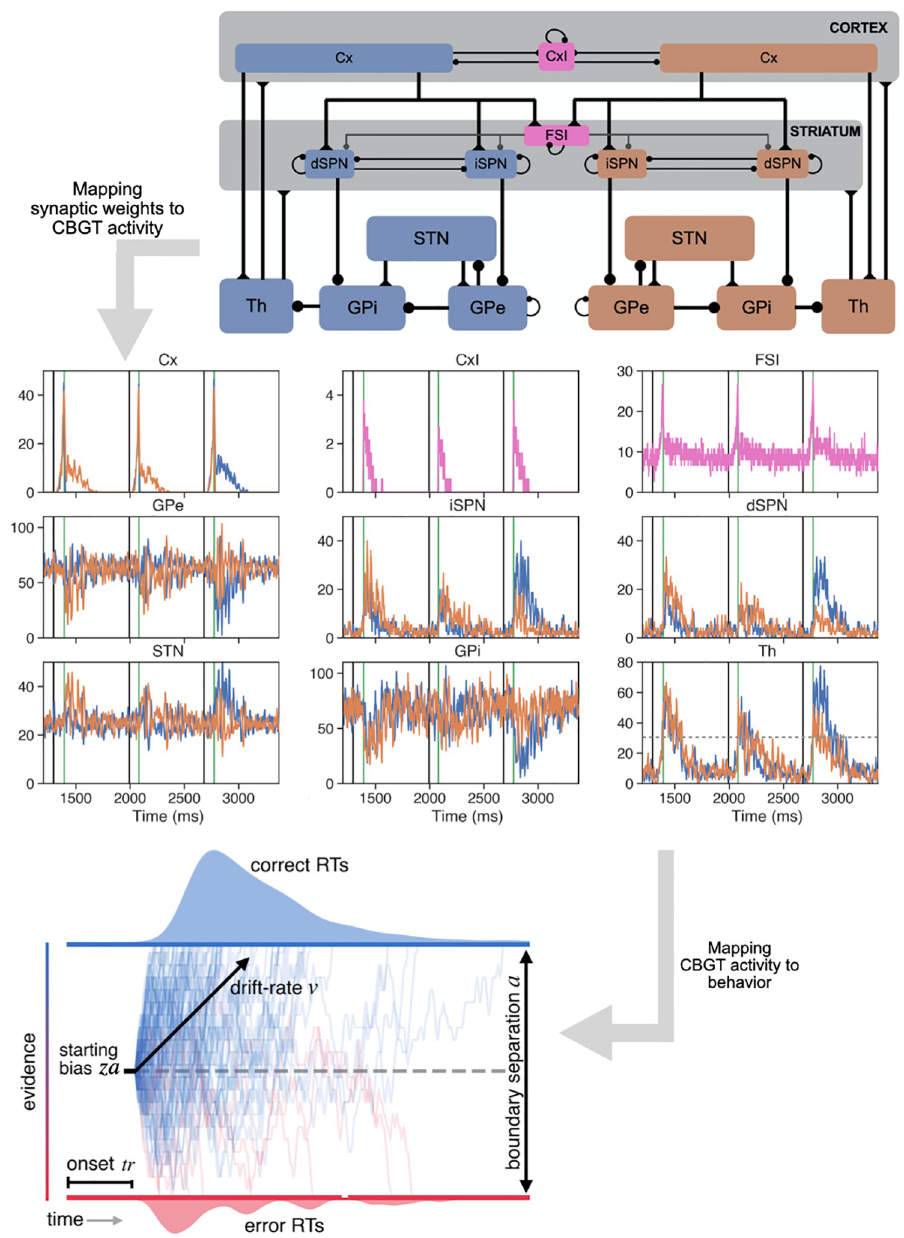
Fig 1. Mapping cortico-basal ganglia-thalamic (CBGT) circuitry to behavioral data. The CBGT network includes neurons from a variety of interconnected populations (see Section Neural activity: CBGT network). Blue nodes and orange nodes represent two distinct action channels, which we call A and B; pink nodes are those populations that interact with both channels. Connection weights, W , in the CBGT network (upper panel) modulate network firing rates, R , (central panel) that in turn map to behavior that can be fit by a DDM (lower panel) after tuning of its parameters, P . In the central panel, black vertical traces indicate the stimulus starting times for three decision-making trials, while the green vertical lines mark the times when the decisions (B,B,A) were made. The horizontal dashed gray line in the thalamus (Th) subpanel corresponds to the decision threshold of 30 Hz . Cx, cortical cells; CxI, cortical inhibitory interneurons; FSI, fast spiking interneurons; dSPN, direct pathway spiny projection neurons; iSPN, indirect pathway spiny projection neurons; STN, subthalamic nucleus; GPe, external globus pallidus; GPi, internal globus pallidus; Th,